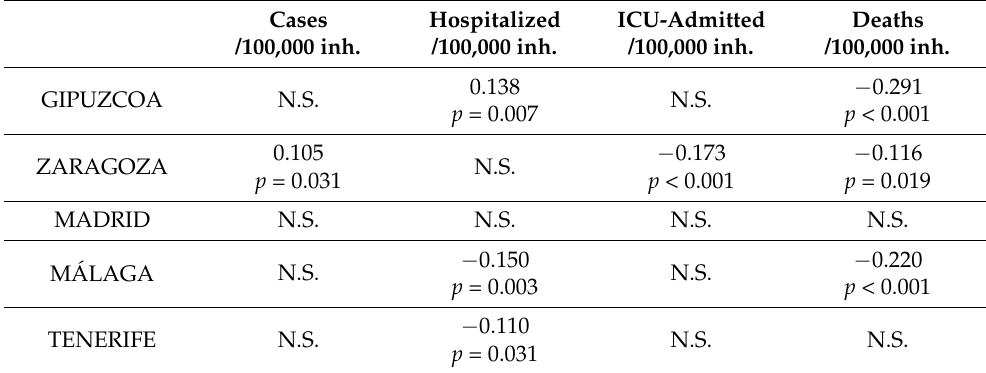
Table 3. Correlations between mean temperature and COVID-19 incidence rate, hospitalized cases, ICU-admitted cases, and deaths per 100,000 inhabitants.